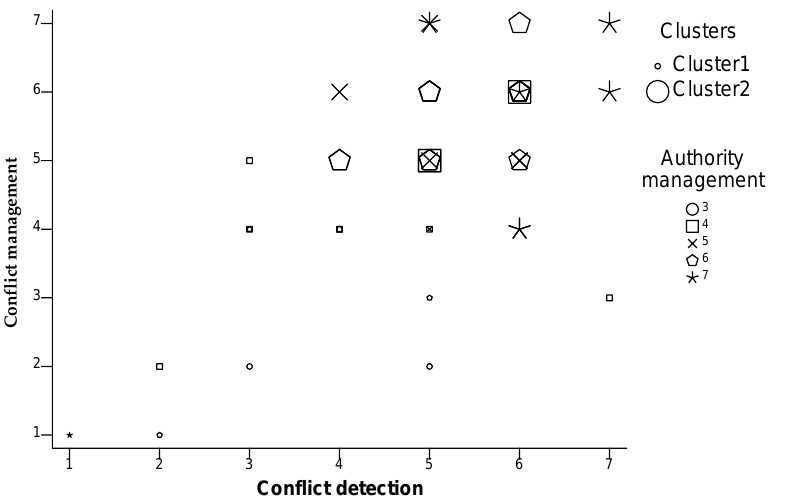
Figure 12. Graphical representation of the clusters formulated from the subjective evaluation of the shuttles KHC regarding conflict detection, conflict management, and authority management.